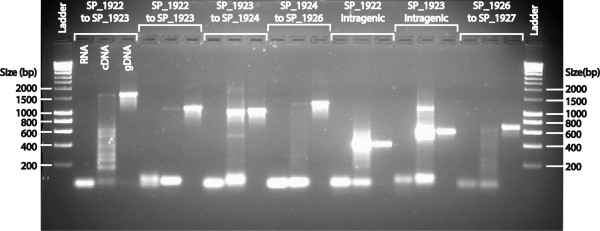
DNA fragments derived from various amplicons of the region spanning SP_1922 – SP_1926. RT-PCR on S. pneumoniae strain TIGR4 grown in rich medium (THYE) showed amplification products of the expected sizes. Lane 1 = Hyperladder I (Bioline). The remaining lanes represent pairs of primers tested on (i) unprocessed RNA (negative control, confirms absence of contaminating gDNA), cDNA (query), and gDNA (positive control), all from strain TIGR4. Primer pairs spanned: SP_1922 and SP_1923 (ply) (lanes 2–4 & 5–7), SP_1923 and SP_1924 (lanes 8–10), SP_1924 and SP_1926 (lanes 11–13), SP_1922 intragenic region (lanes 14–16), SP_1923 intragenic region (lanes 17–19), and SP_1926 and SP_1927 (negative control, lanes 20–22). It should be noted that the band of the highest molecular weight in the cDNA lane of the negative control (lane 21) is smaller than the band in the gDNA lane (22) and is part of a non-specific smear of amplification.